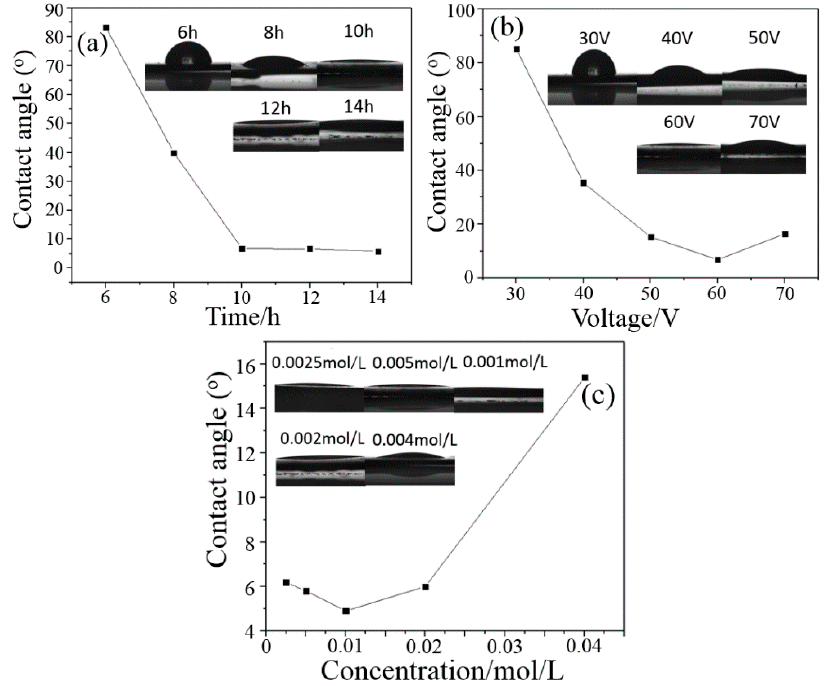
Figure 12. Hydrophilic property of TiO 2 nanotube arrays and Gd-doped TiO 2 nanotube arrays prepared at ( a ) different times (6 – 14 h) , ( b ) different voltages (30 – 70 V) and ( c ) different Gd 3+ concentrations (0.0025 – 0.04 mol/L).